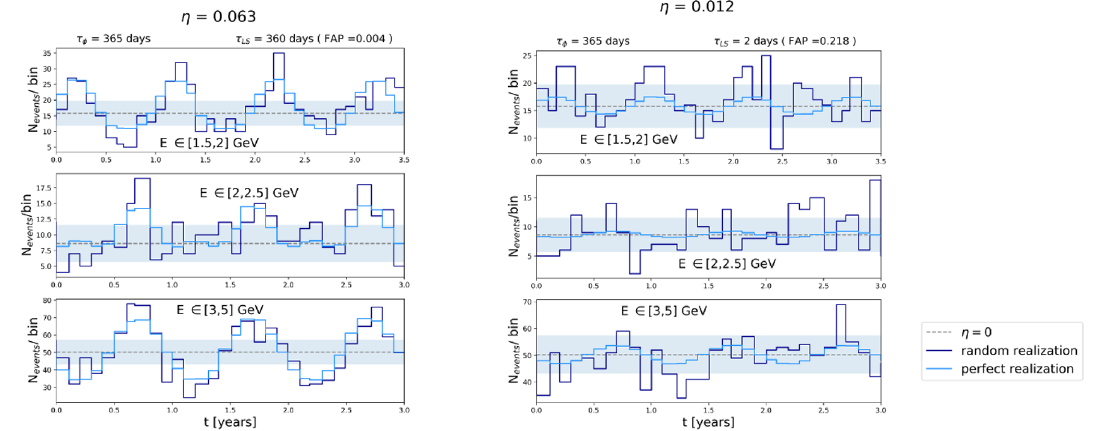
Figure 5 . Expected number of events in different time bins at three different energy bins for a particular realisation of DUNE. Gray dashed lines represent the number of events expected with η = 0 and the shadowed region corresponds to the 1 σ statistical uncertainty. Light blue lines are the expected signal with non-zero η and m φ , while dark blue lines represent a random realisation of the signal which includes statistical fluctuations. Left panel corresponds to a set of parameters ( η, m φ ) in the 90 % CL region above shown. Right panel corresponds to a point in the η − m φ plane which LS method would not identify the frequency